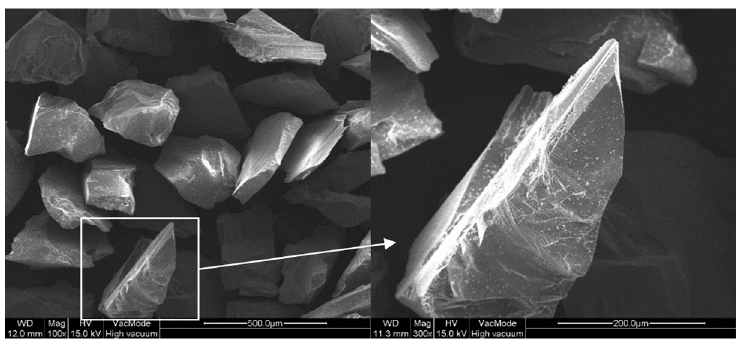
Figure 5. Images of alumina abrasives measured with a scanning electron microscope.